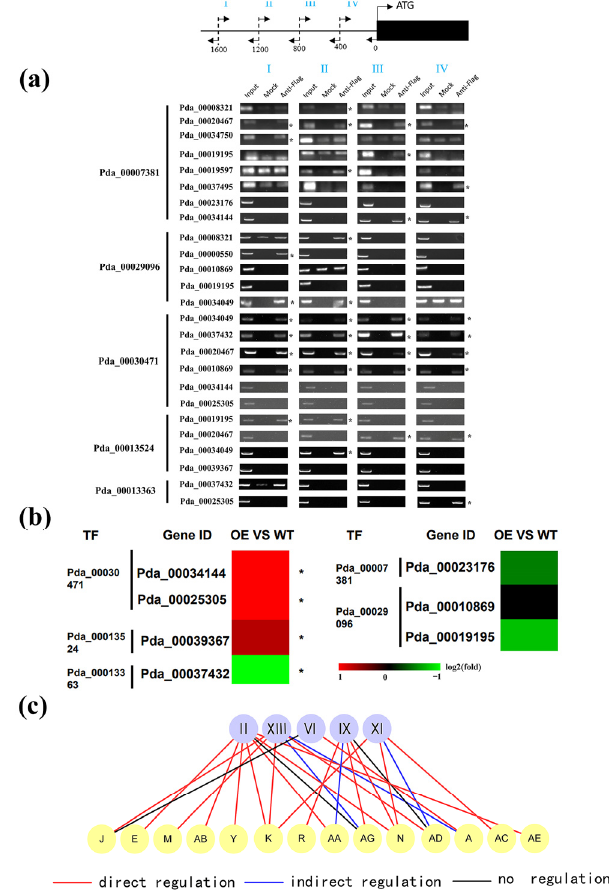
Figure 2. Verification of the regulatory relationship between the first and second layers in the GRN. ( a ) Verification of the direct regulatory relationships of the TFs between the first and the second layers using ChIP-PCR. The promoters ( − 2000 to 0 bp) were divided into four equal-length fragments (I to IV) for ChIP-PCR (right panel). Input, mock, and anti-FLAG indicate the chromatin before immunoprecipitation (IP), IP with no antibody (mock), and IP with anti-FLAG antibody (anti-FLAG), respectively. An asterisk (*) indicates the binding of TF to the truncated promoters. ( b ) Verification of indirect regulatory relationship using qRT-PCR. The heatmap represents the relative expression (fold change) of the genes in transiently transformed poplar plants overexpressing each TF relative to the control. Red indicates up-regulation; green indicates down-regulation. An asterisk (*) indicates significant regulation ( p < 0.05). ( c ) A summary of the regulatory relationship between the first and second layers in the GRN. The gene names are shown in Table S5.